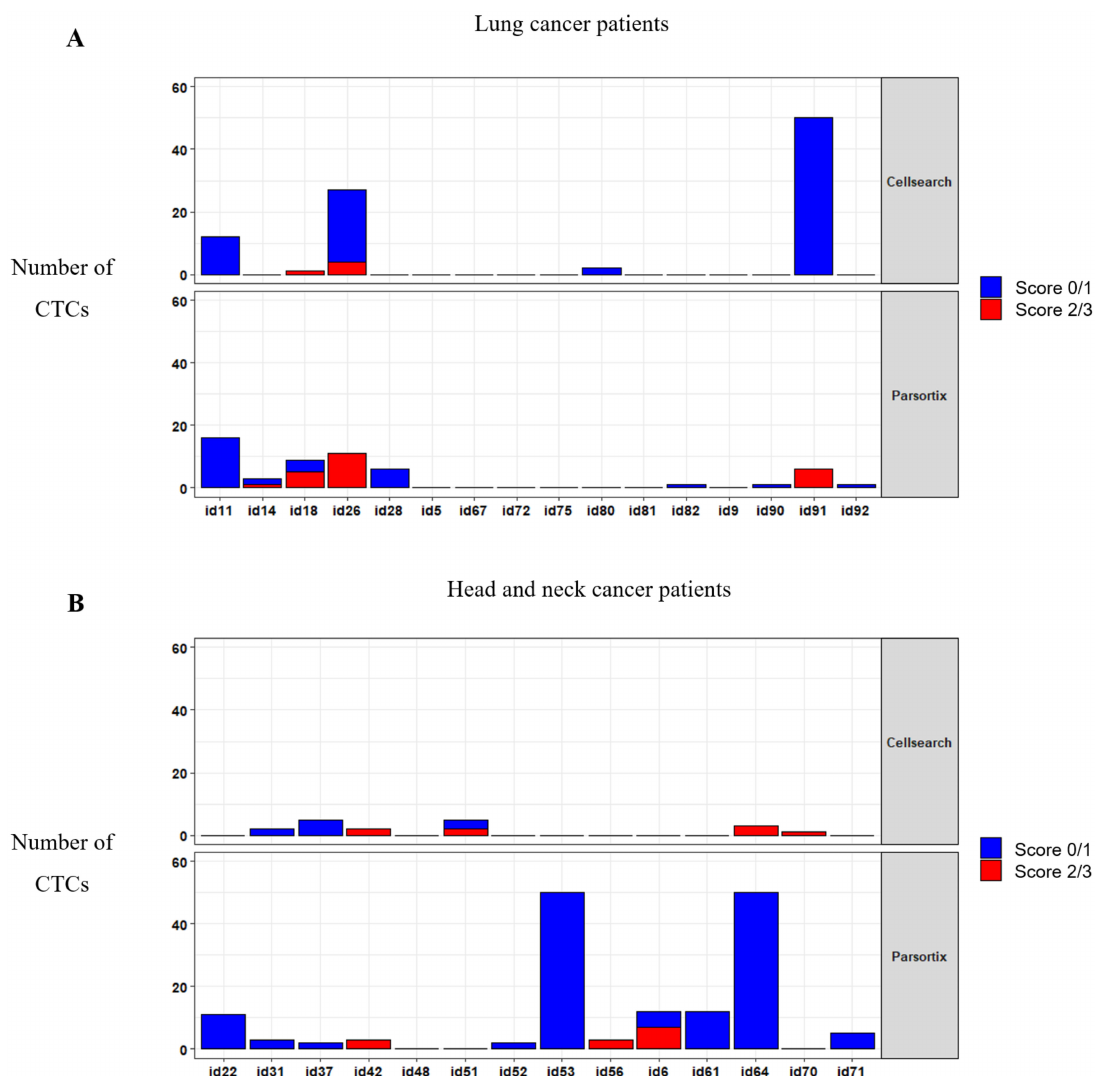
Figure 6. CTCs enumeration and MET expression in blood samples evaluated by the CellSearch ®